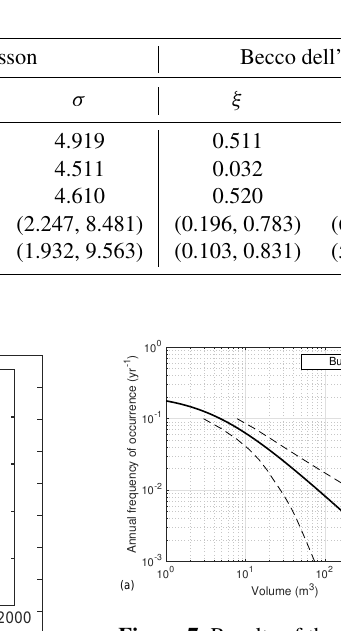
Figure 7. Results of the bootstrap analysis on the records on Buis- son and Becco dell’Aquila sites. The continuous lines are plotted from Eq. (14) with the parameters reported in Tables 2 and 4. The dashed lines are the bounds of the 90% confidence intervals. In or- der to easily compare the two, the bounds of the axes are kept equal on the two